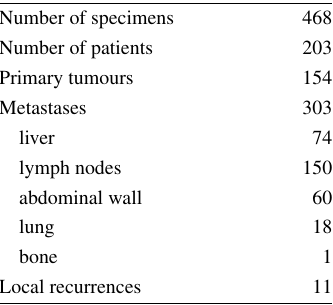
Cases used for Tissue Microarray